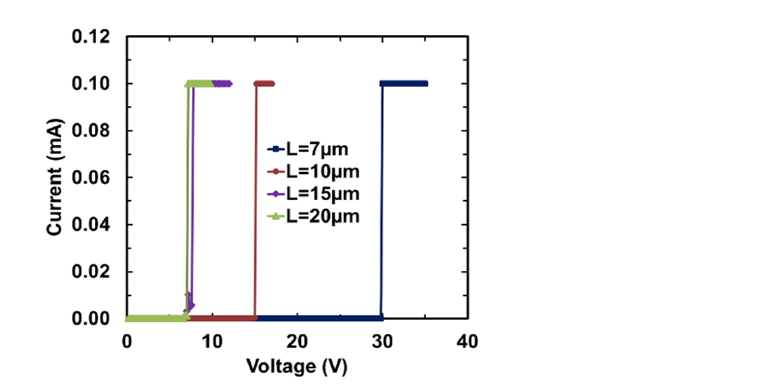
Figure 10. A sample gNEMS switch shows the I–V characteristics of dual-directional ESD under TLP testing.